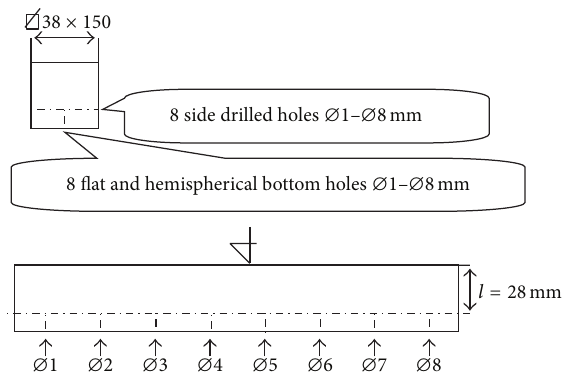
Figure 8: Pictorial diagram of the hole configuration in the steel bars.